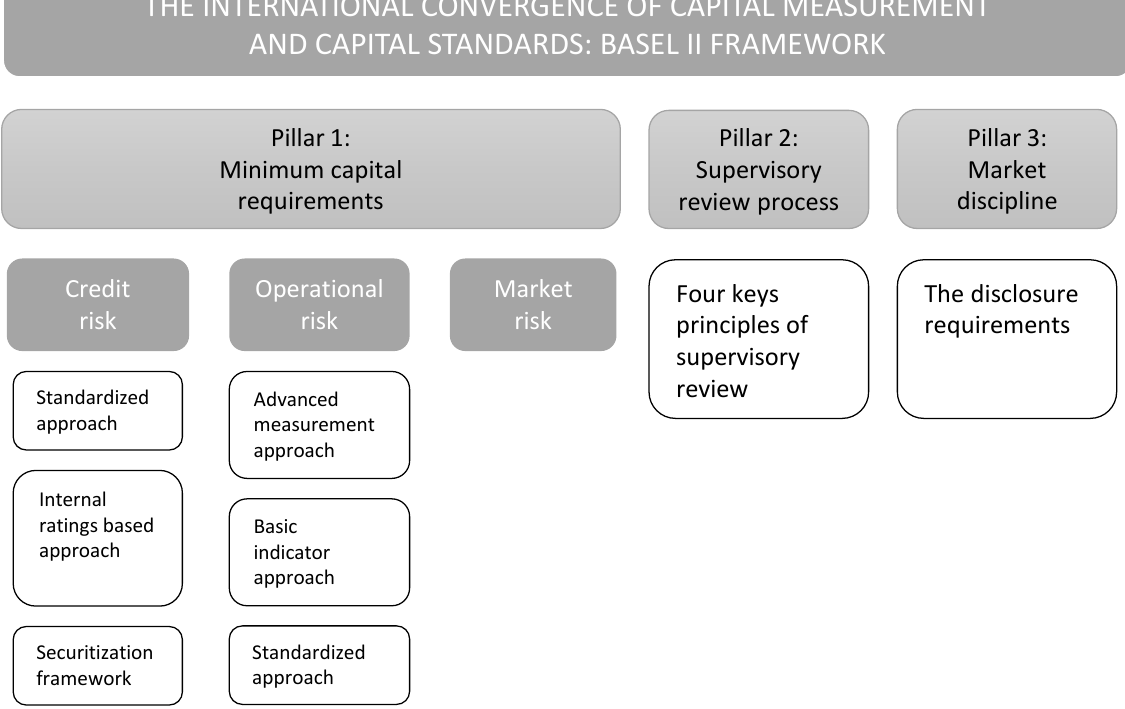
Figure 1. Basel II